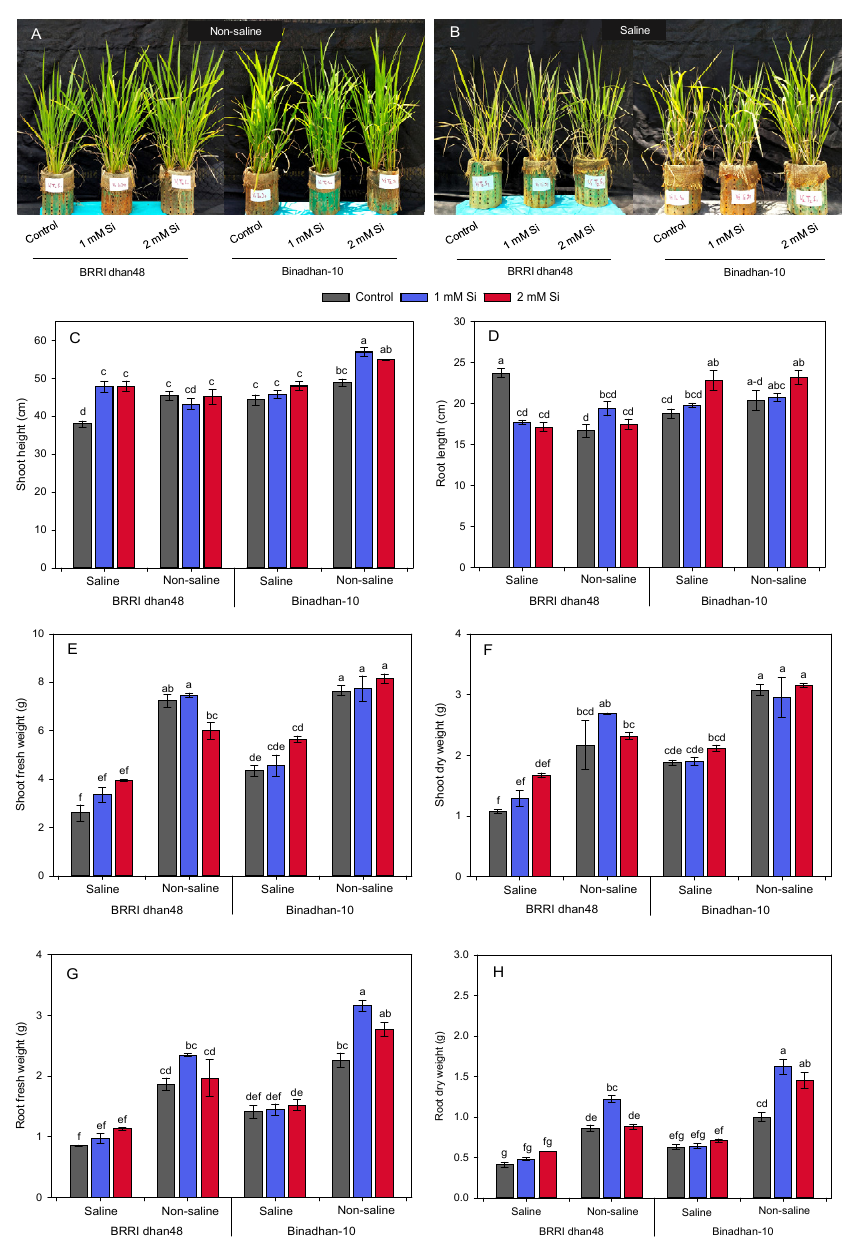
Figure 1. Effect of Si supplementation (1 and 2 mM silicic acid) on rice plants subjected to salt stress (10 dSm − 1 NaCl). ( A , B ) Showing comparative phenotypes of BRRI dhan48 (salt-sensitive) and Binadhan-10 (salt-tolerant) with or without Si pre-treatment under salinity, ( C ) shoot length, ( D ) root length, ( E ) shoot fresh weight, ( F ) shoot dry weight, ( G ) root fresh weight and ( H ) root dry weight were recorded after six days of recovery from salt tress. Different letters above the bars indicate significant differences among the treatments following Tukey’s HSD test.